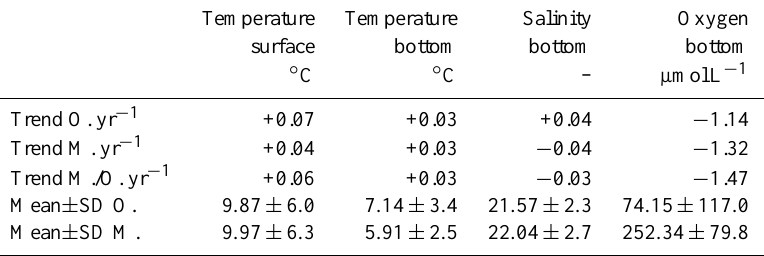
Table 6. Comparison of linear trends in observed and modelled parameters temperature (surface and bottom layer), salinity and oxygen concentration (bottom layer). To ensure comparability, trends only relate to the period 1970–2010, limited by the model output. Note that the bottom layer is at a depth of 25m in the observations but 21–24m in the model. O: observations; M: BSIOM output; M./O.: model output only on days with BE